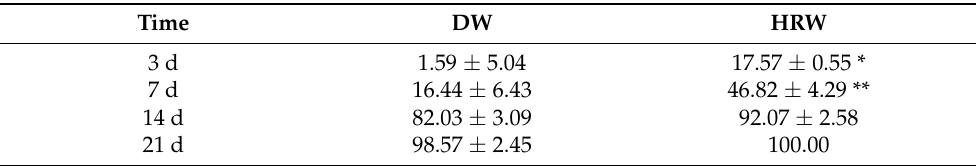
Table 2. The Wound healing rate (%) in DW and HRW groups at days 3, 7, 14, and 21. * p < 0.05, ** p < 0.01.